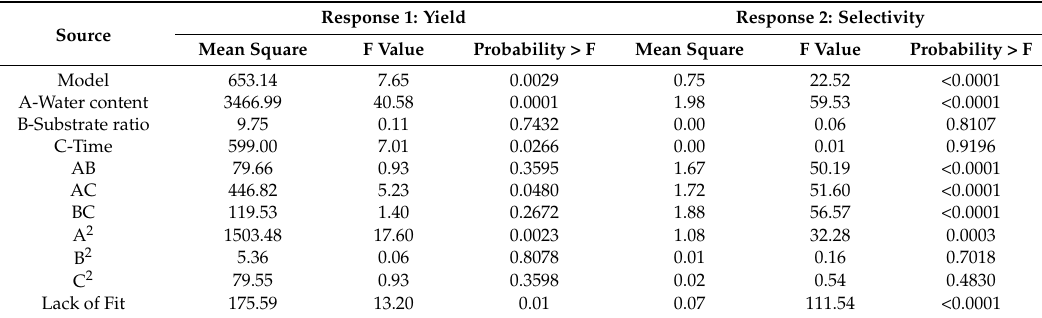
Table 3. Results of the regression analysis of the central composite design for AFA